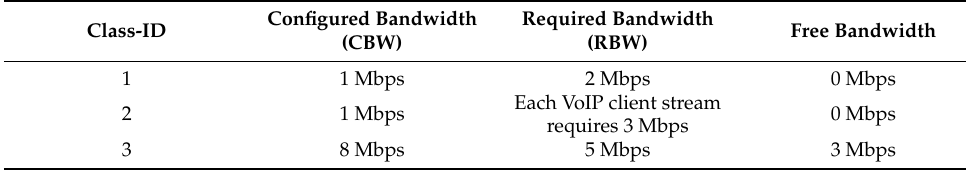
Table 10. Scenario 2 Adaptation